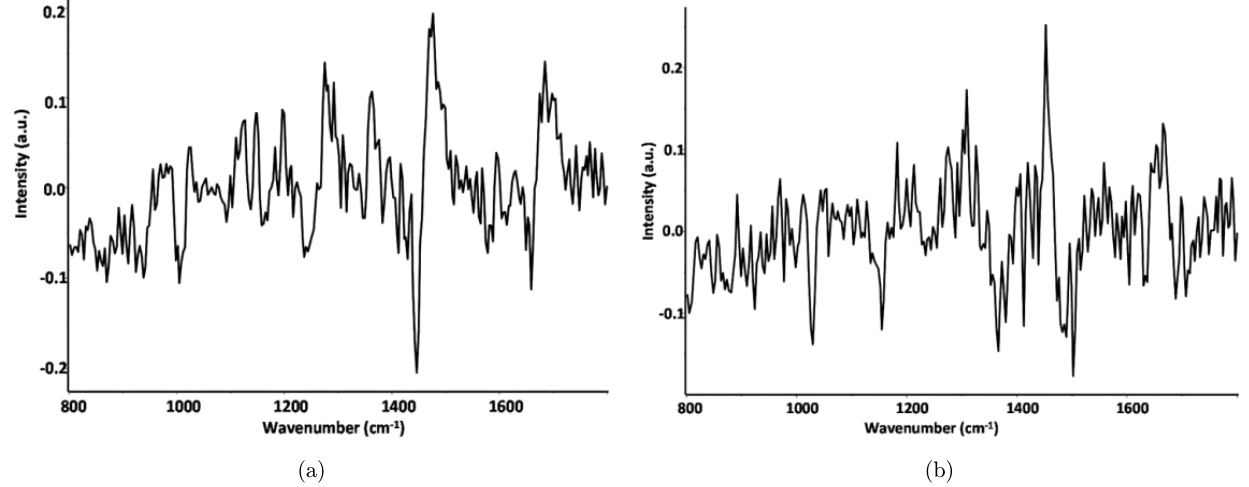
Fig. 5. Loading plots of factors used for classi¯cation (a) Factor 1 (b) Factor 2.